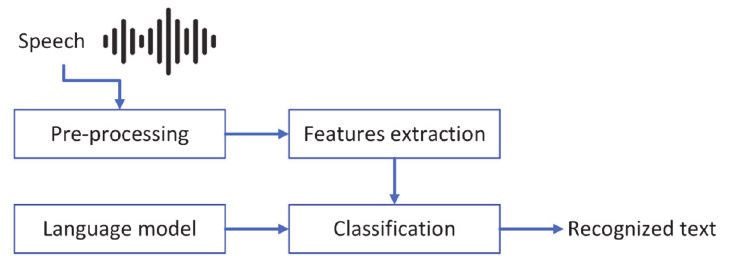
Figure 1. Automatic speech recognition